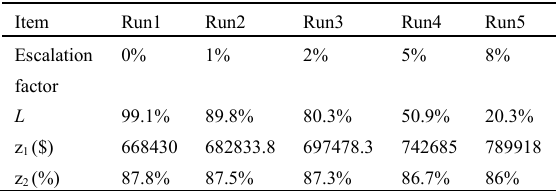
Table 8. Results of the sensitivity analysis in terms of changes in escalation